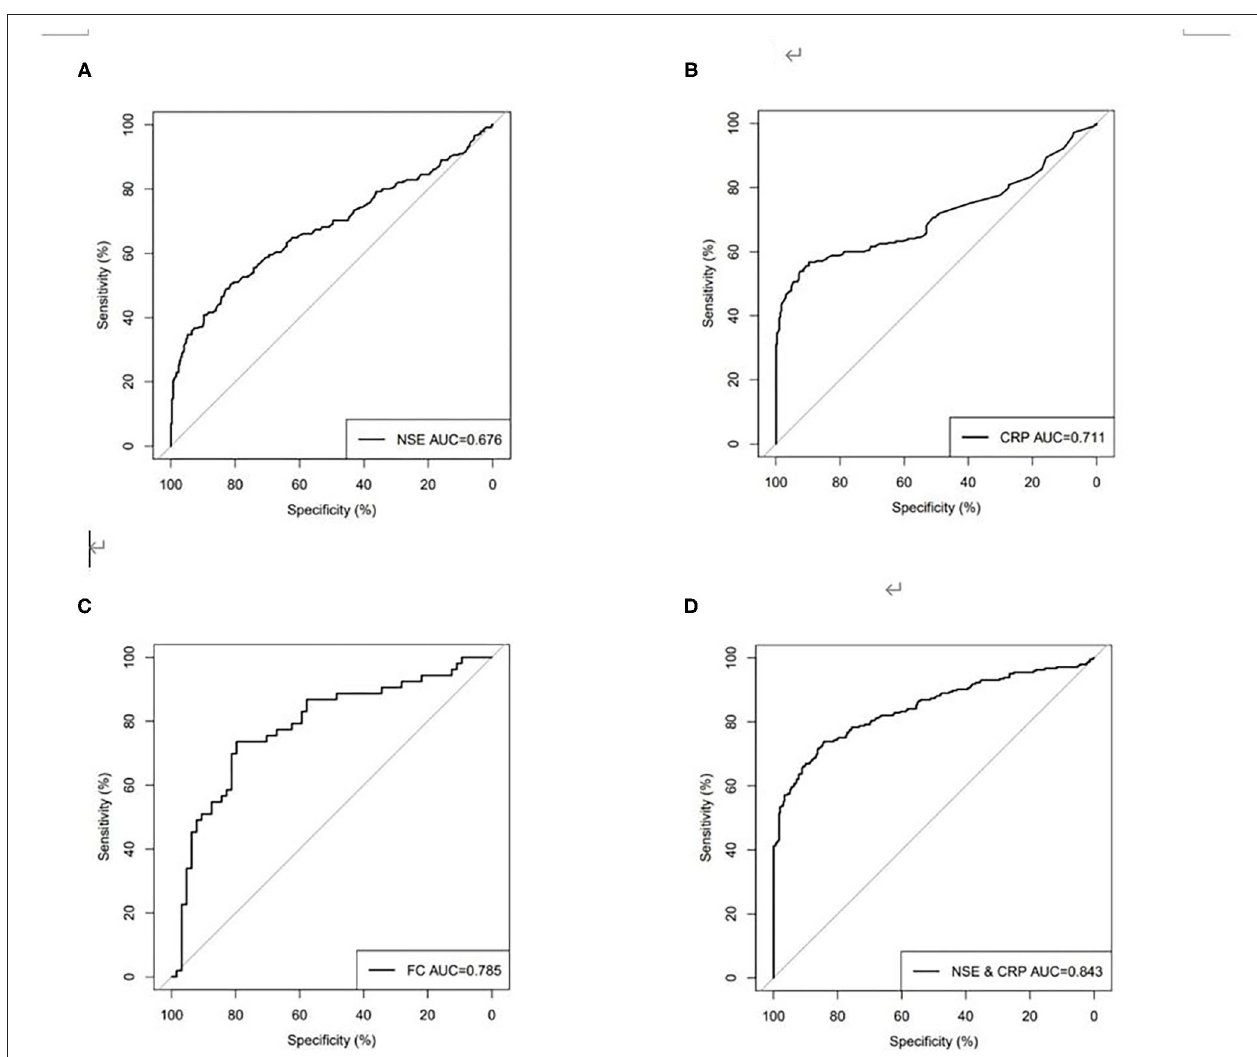
FIGURE 3 | Receiver operating characteristics (ROC) curves for (A) NSE, (B) CRP, (C) FC, (D) combined NSE and CRP for discriminating between patients with CD and healthy people.